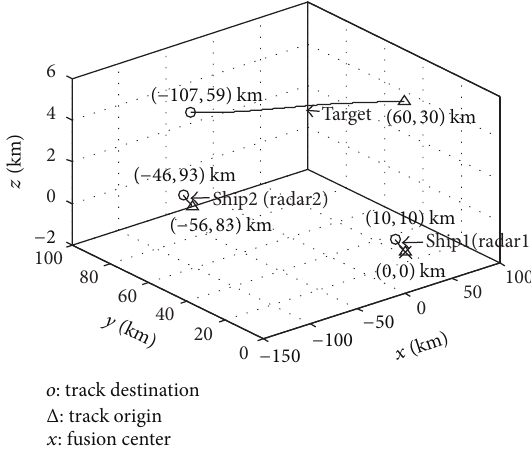
Figure 5: The geometry of radar and